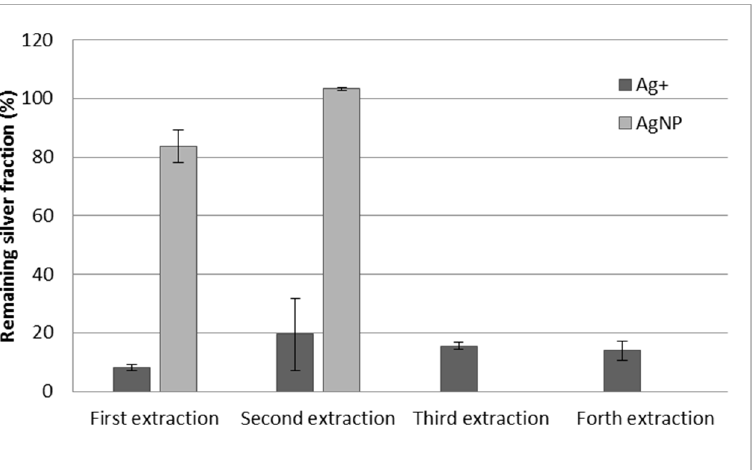
Figure 5 . Reuse of the resin after 4 adsorption cycles. Error bars represent standard deviation n = 2. Initial silver concentration is 100 μg·kg − 1 for both Ag + and